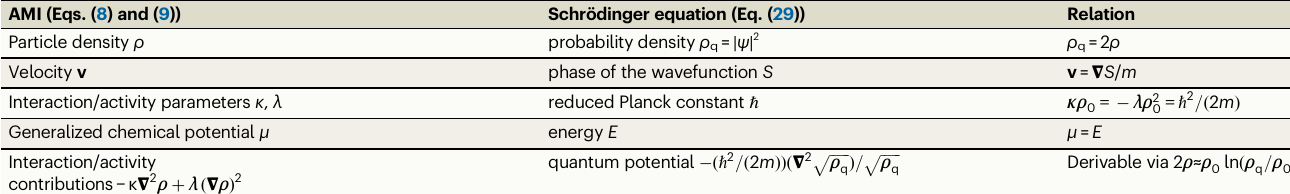
Table 1 | Correspondences between variables and terms in AMI and in the Schrödinger equation AMI (Eqs. (8) and